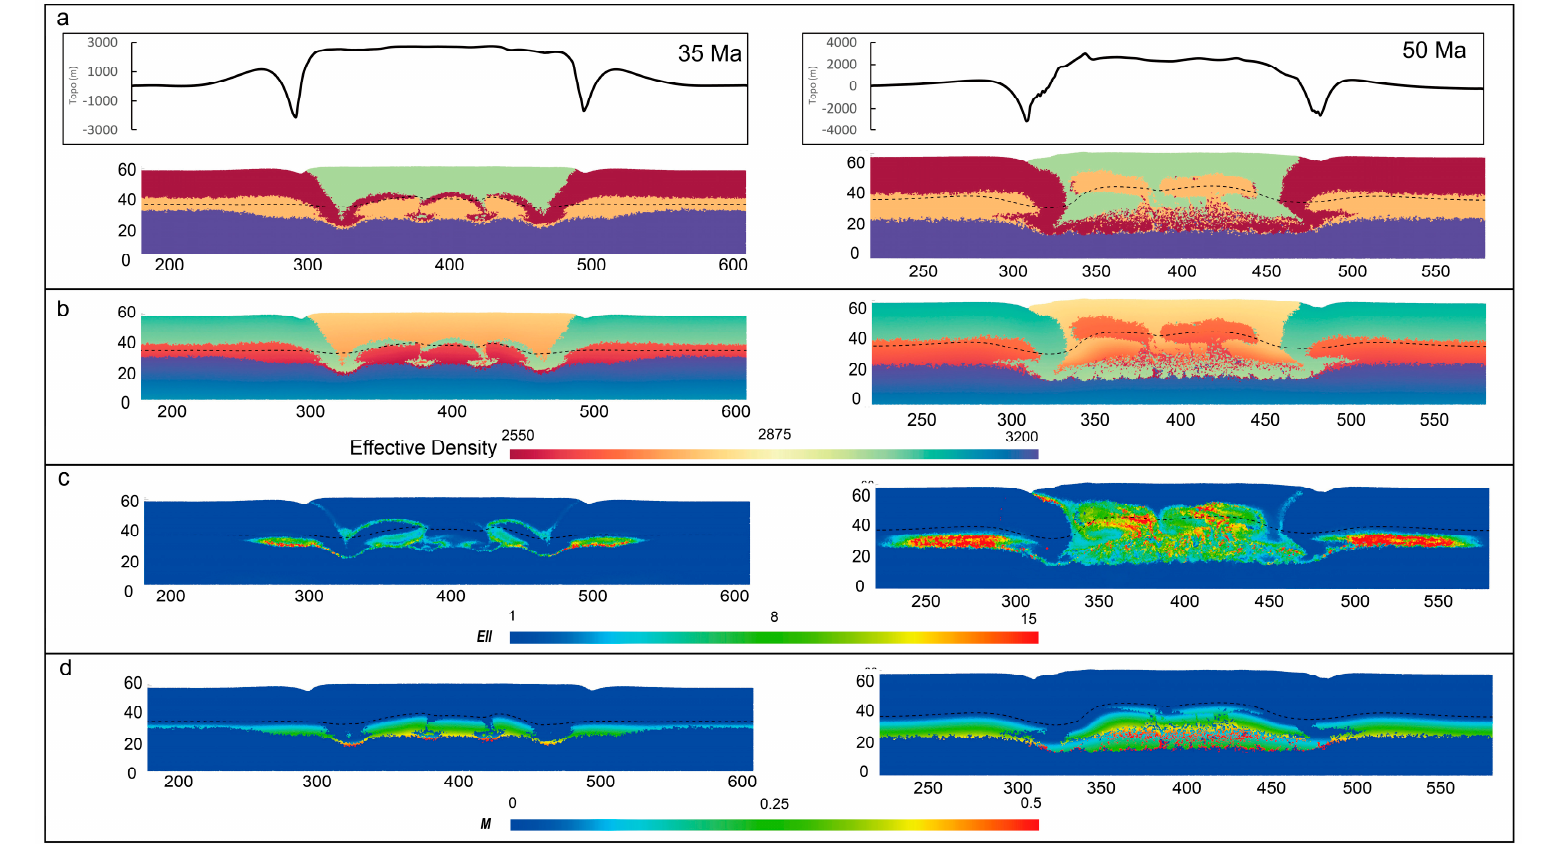
Figure 9. Model290, the width of sediment is set to 290 km. The solidus temperature of the lower crust is shown in dashed line. ( a ) At 35 Ma, lower crustal rocks form three crustal-scale folds. Moderate-high pressure volcano-sedimentary rocks are preserved in two-fold hinges. As convergence continues (50 Ma), partially molten lower crustal rocks ascend into the sedimentary basin and form two similar diapirs. ( b ) Effective density is calculated by Equations (5) and (6). ( c ) The accumulation ( EII ) of the second invariant of the strain rate ( ε II , s − 1 ) is employed to identify shear zones over time (calculated by EII = ∑ t )). ( d ) Melt fraction is obtained by Equations (2) and (3).